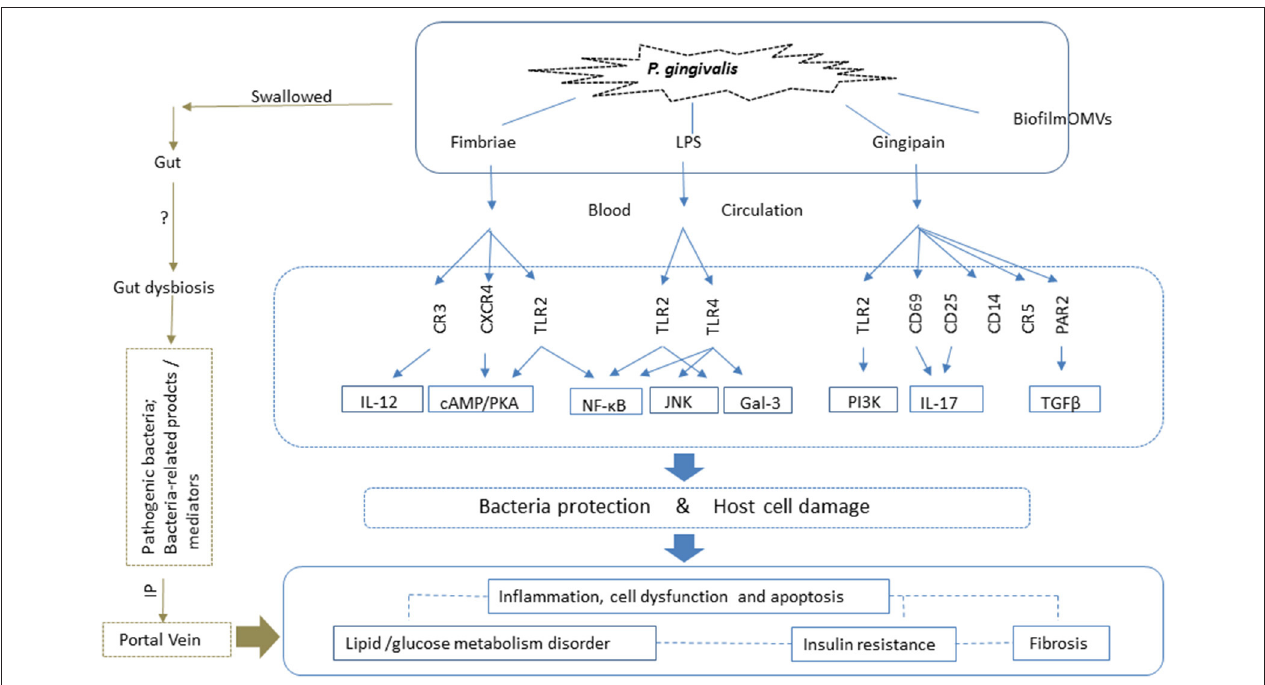
FIGURE 2 | P. gingivalis impacts NAFLD via both the oral-liver and oral-gut axes. With respect to the oral-liver axis, P. gingivalis and its virulence factors can reach the liver directly via the blood circulation. Virulence factors such as fimbriae proteins, lipopolysaccharide (LPS) and gingipains elicit inflammatory immune reactions and activate intracellular signaling pathways by binding to the corresponding receptors. This results in inflammation, cell death, and dysfunctions, all of which are closely related to glucose and lipid metabolic disorders, insulin resistance, and fibrosis, which contribute to the pathogenesis of NAFLD. Biofilm and outer membrane vesicles (OMVs) play roles in the transfer of bacteria and virulence factors, such as gingipains, to the liver, the site of pathogenic action. P. gingivalis also affects NAFLD via the oral-gut-liver axis. It can enter the gastrointestinal tract via swallowing, where it can induce dysbiosis of the gut microbiota and enhance intestinal permeability. Thus, both the pathogenic bacteria, and related toxic products and mediators, can reach the liver via the portal vein, and play a role in NAFLD. LPS, lipopolysaccharide; TLR, Toll-like receptor; IL, interleukin; OMVs, outer membrane vesicles; CXCR, CXC-chemokine receptor; CR, complement receptor; cAMP, cyclic adenosine monophosphate; PKA, protein kinase A; NF- κ B, nuclear factor kappa B; TGF- β , transforming growth factor β ; PAR, proteinase-activated receptor; JNK, c-Jun-NH2-terminal kinase; IP, intestinal permeability; Gal, galectin; PI3K, phosphatidylinositol-3